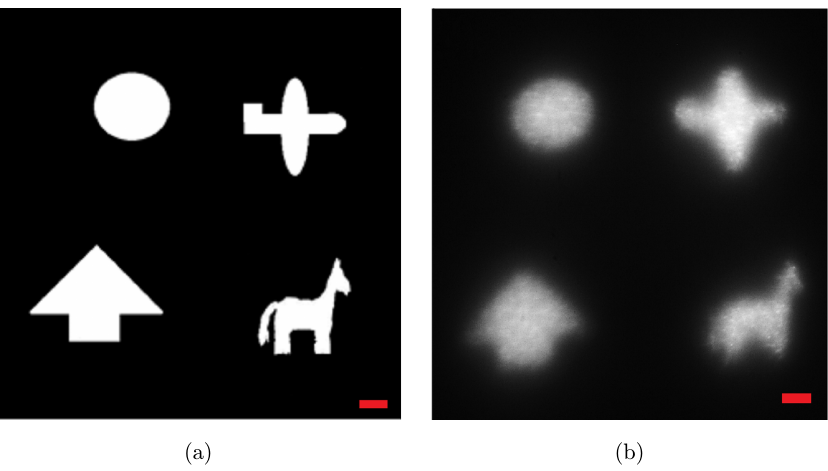
Fig. 2. The process of imaging the arbitrary shapes of the samples. (a) The required excitation light pattern including four di®erent shapes and (b) the two-photon °uorescence image of 5% rhodamine solution excited by the required excitation light pattern. Scale bar is 10 (cid:1)